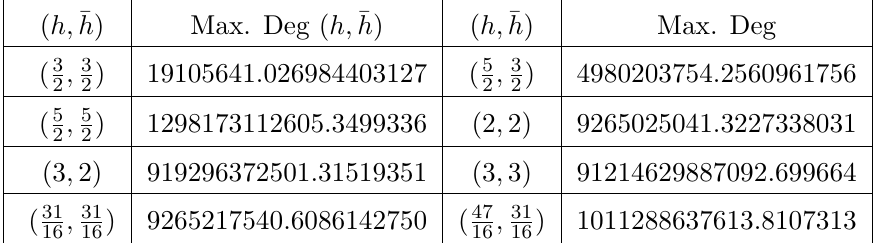
Table 15. This table summarizes the maximal degeneracies of the (cid:12)rst few states in a gapped c = 47 = 2 CFT. The maximum number of derivatives is set to N max = 65, (cid:14) = 10, while the spin is truncated at j max =